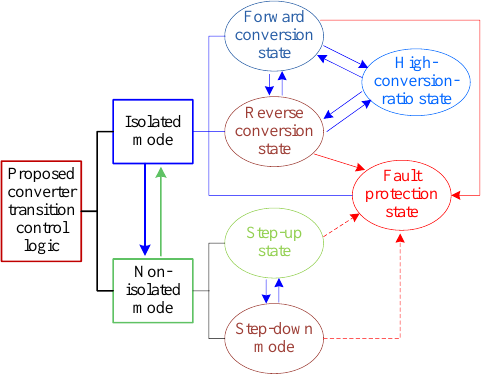
Figure 10. The transition control logic diagram of proposed converter.